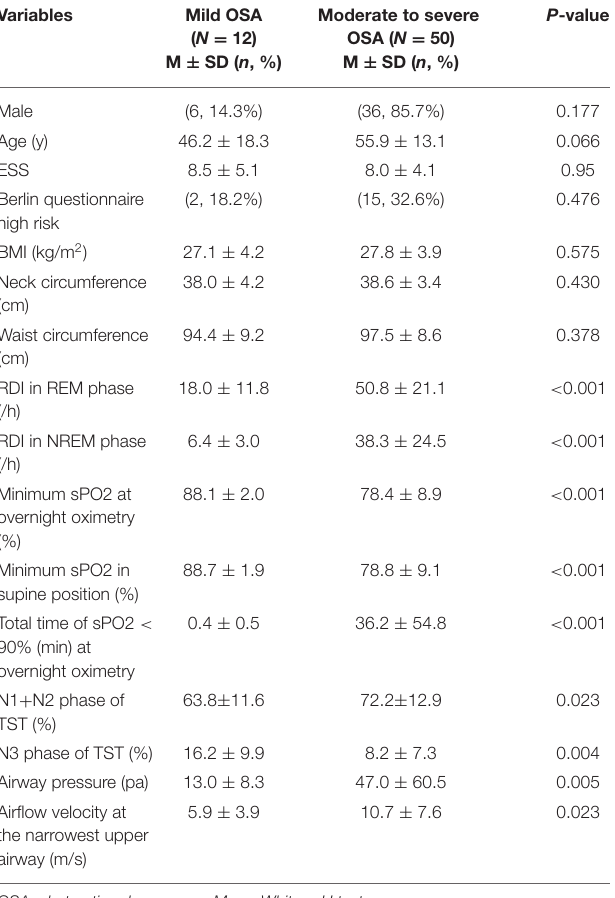
TABLE 2 | Results for patients with mild OSA and patients with moderate to severe OSA. Variables